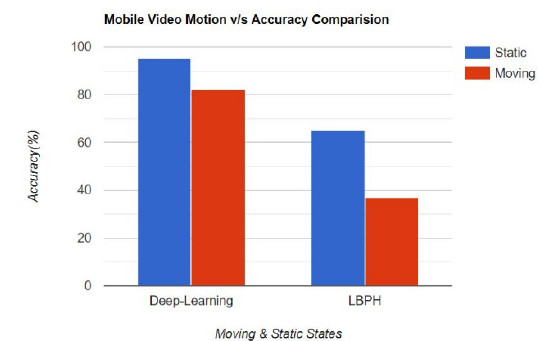
Figure 7 . Histogram shows the CCTV video Motion comparison of both algorithms i.e. LPBH and Deep